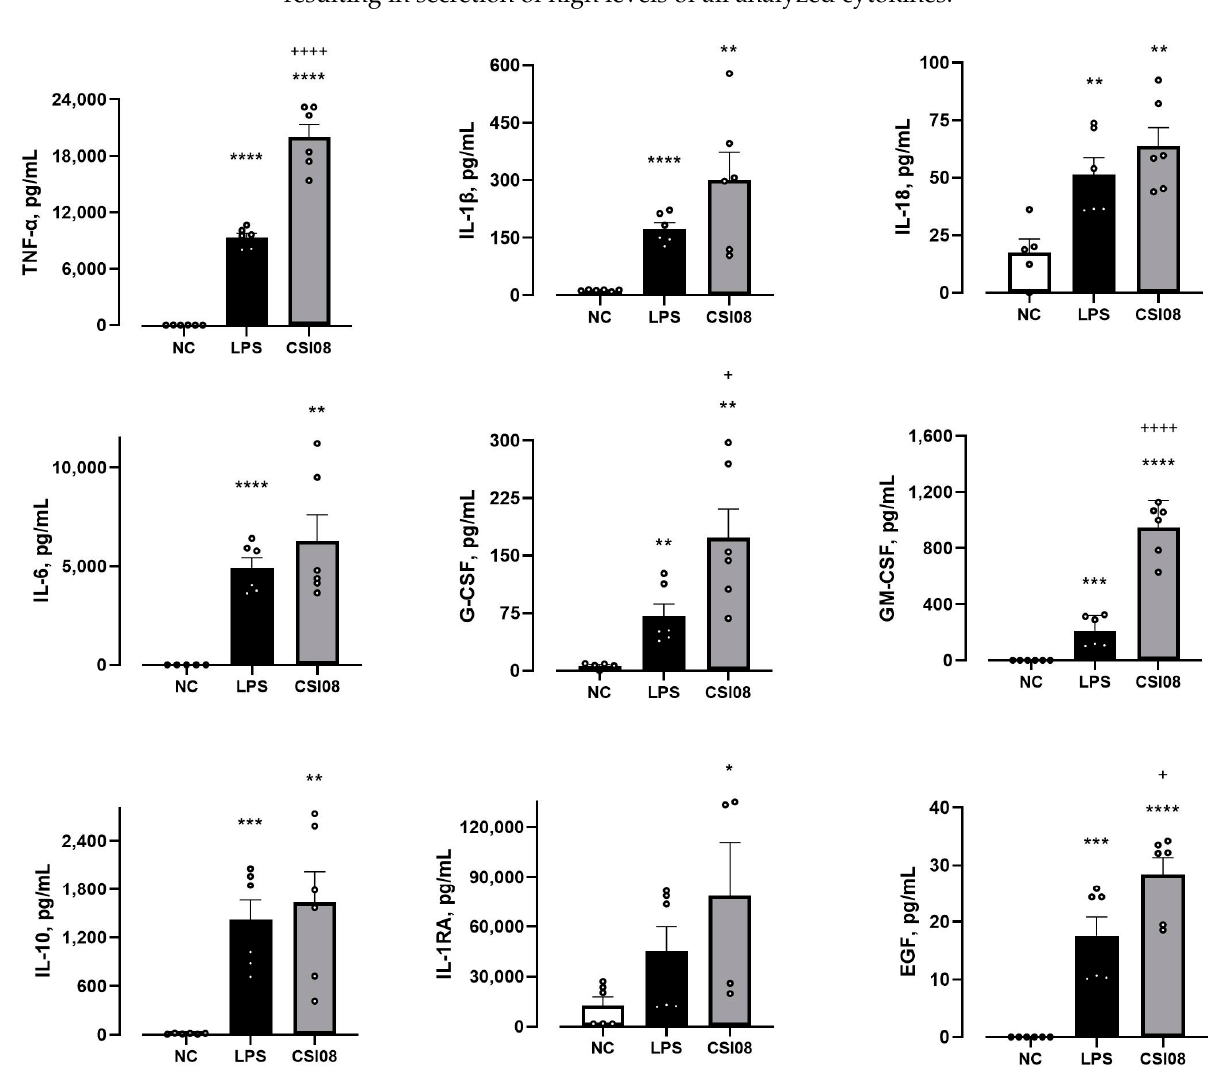
Figure 9. Immunostimulatory effect of B. clausii CSI08. Cytokine levels in cell culture supernatants of U937-derived macrophages: untreated (NC) or challenged with 10 8 CFU/mL of vegetative cells of B. clausii CSI08 or LPS for 5 h. Values are the means ± SEM of three independent experiments. * p < 0.05, ** p < 0.01, *** p < 0.001; **** p < 0.0001 LPS or CSI08 vs. NC; + p < 0.05; ++++ p < 0.0001 CSI08 vs. LPS.